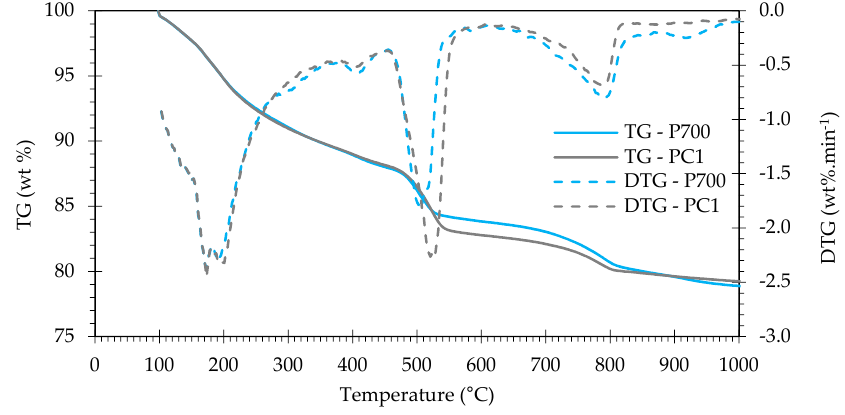
Figure 20. Thermogravimetric (TG) and first derivative (DTG) analysis of PC1 and P700 at 28 days. Table 8. Estimated Ldh , Ldx , Ldc , Wb , α TG and CH contents of PC, PNT and RC pastes at 28 days.